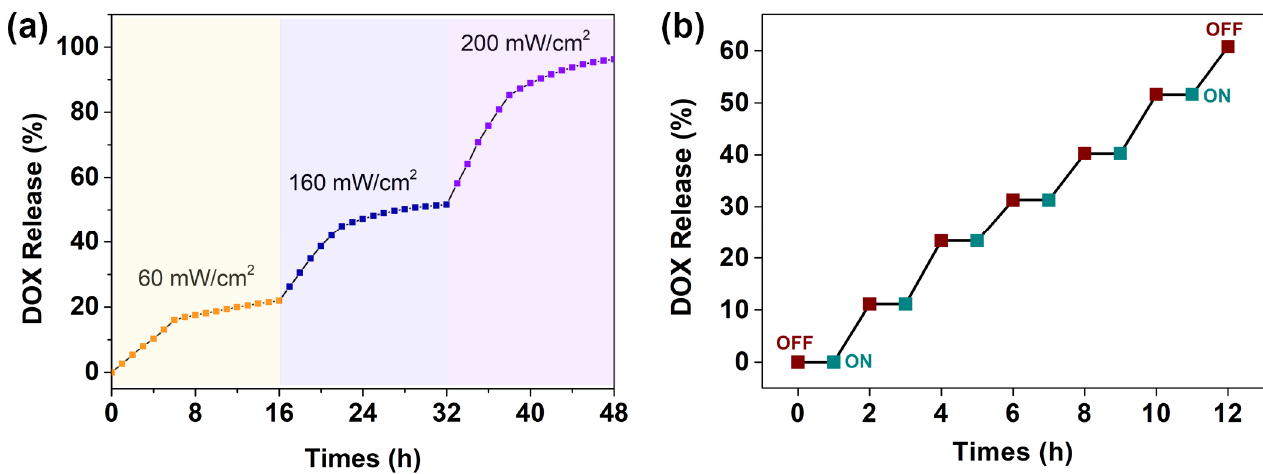
Figure 7. ( a ) DOX release profiles of DOX@BPS at different laser intensities in PBS buffer solution (pH 7.4) at 37 °C. ( b ) Progress of release of DOX under light irradiation and dark conditions; “ON” indicates the beginning of light irradiation and “OFF” indicates the ending of light irradiation.